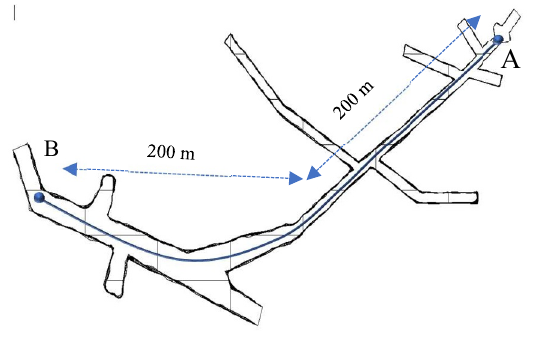
Fig. 2. CANMET Schematic .